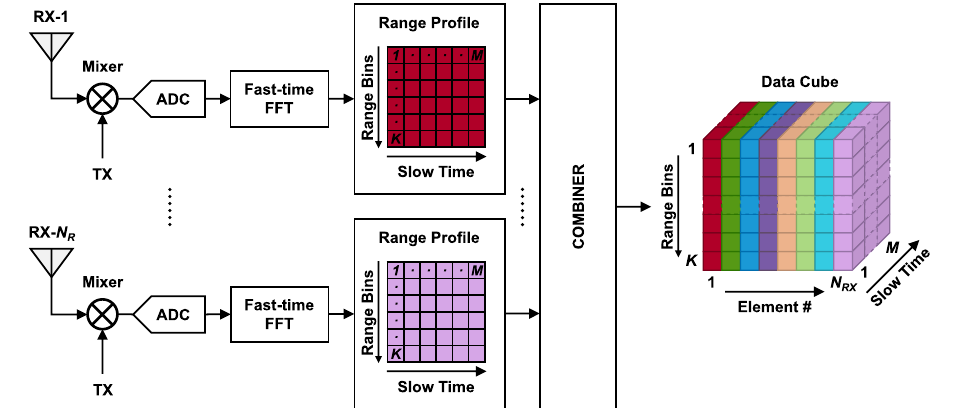
Figure 2. Block diagram of the data cube generation.